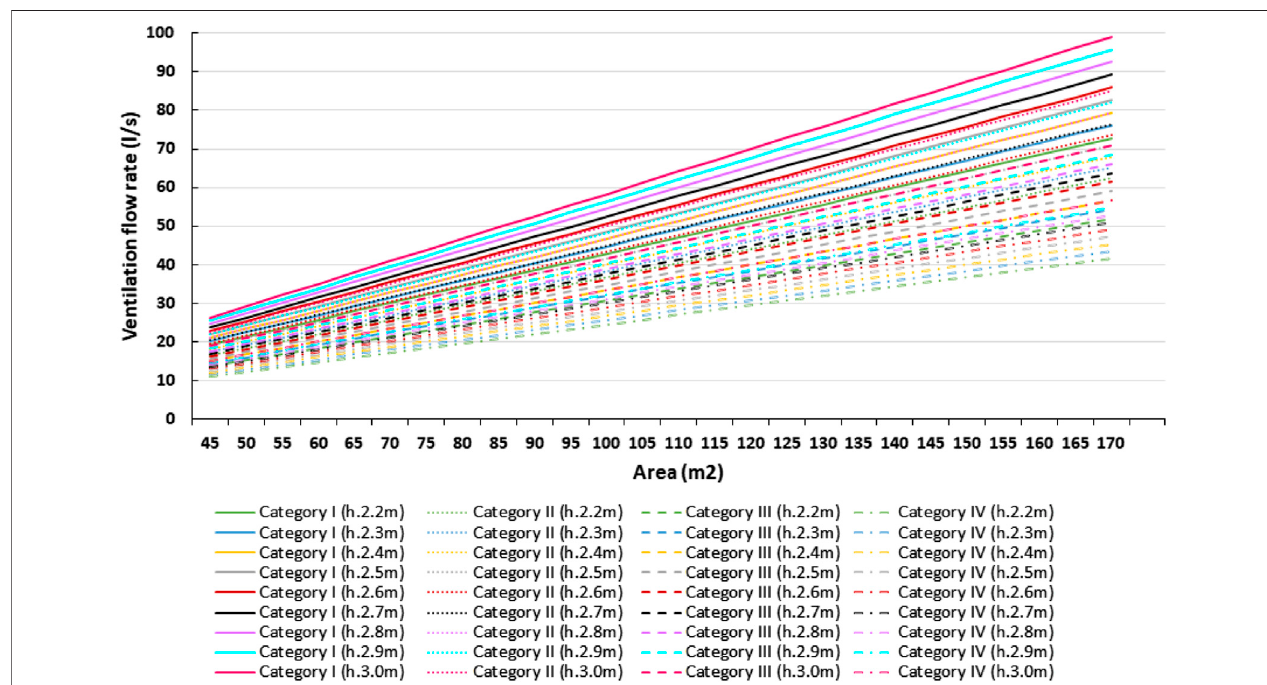
FIGURE 2 | Relationship between ventilation fl ow rate, fl oor area, and height of the house (EN 16798 – 2 method 1).